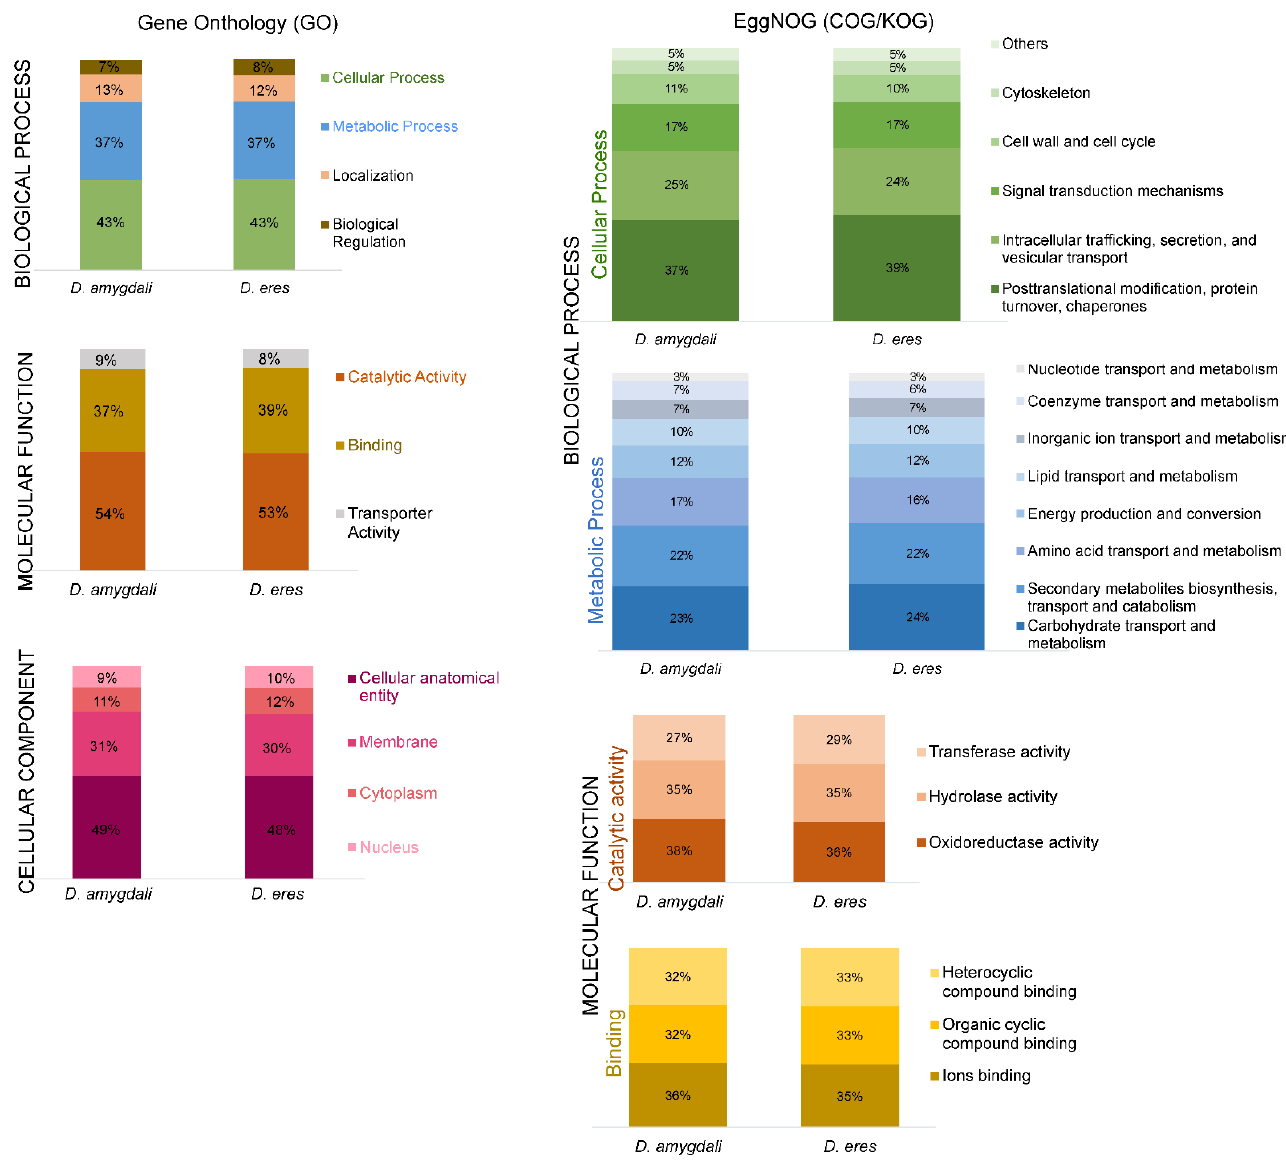
Figure 1. Gene ontology (GO; left panel) and EggNOG functional annotation (right panel) of Diaporthe amygdali CAA958 and Diaporthe eres CBS 160.32.